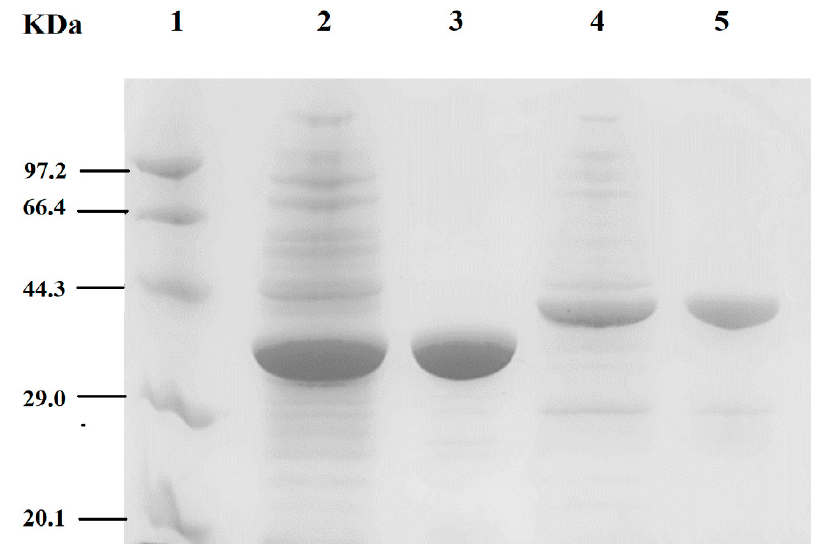
Figure 3. Sodium dodecyl sulphate polyacrylamide gel electrophoresis (SDS-PAGE) analysis of BpTA-1 and BpTA-2. Lane 1. Protein marker (14.3–97.2 kDa); Lane 2. Crude fractions of BpTA-1; Lane 3. Purification fractions of BpTA-1; Lane 4. Crude fractions of BpTA-2; Lane 5. Purification fractions of BpTA-2.